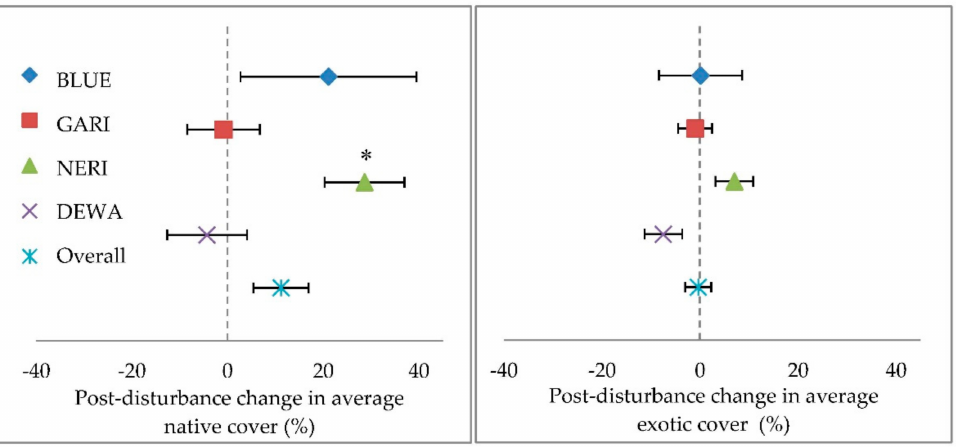
Figure 3. Tukey method comparison for differences of means (disturbed–undisturbed) for changes observed in average plant cover (%) for native ( left panel ) and exotic ( right panel ) average plant species cover (%) between the disturbed and undisturbed plots for each NPS unit and for all the units combined following the disturbance events. There were no significant differences observed except for the difference in change of average native plant cover in NERI. Error bars represent +/ − one standard error of the difference. Asterisks represent a p -value of <0.05. Appendix A and Table A7 contain a list of the means and sample sizes. The y -axis (dashed line) meets the x -axis (solid line) at zero. Pre- and post-disturbance means as well as standard errors can be found in Table